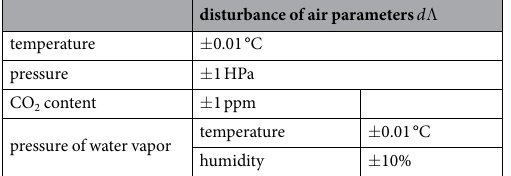
Table 1. The disturbance of air parameters and its influence to